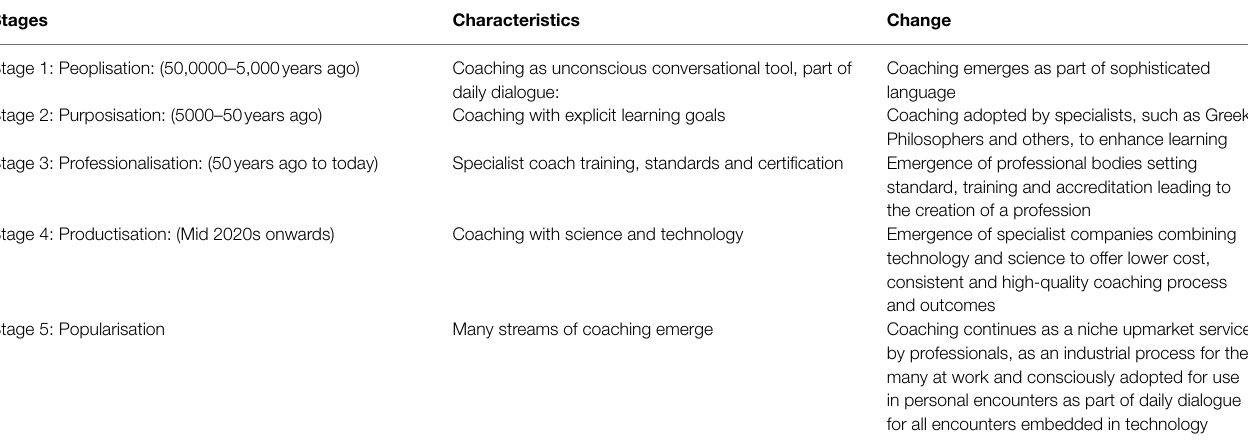
TABLE 3 | 5P’s model of coaching industry